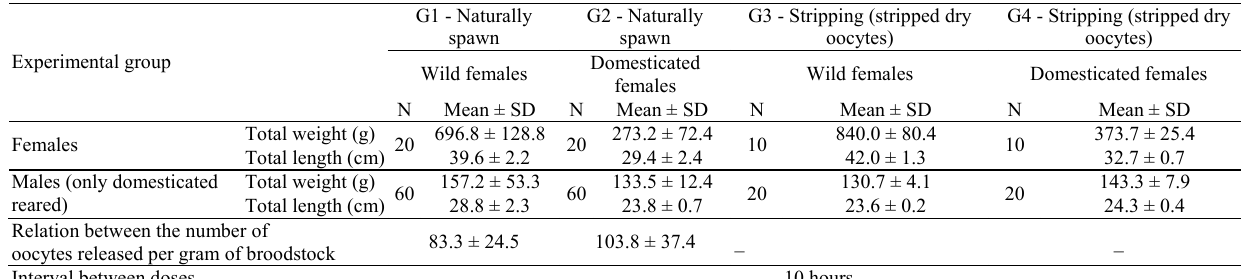
Table 1. Data on Salminus hilarii reproduction at the Ponte Nova Fish Farm during their reproductive periods (from: 2005 to 2007). Four artificial reproductions for G1 and G2 and two artificial reproductions for G3 and G4 were obtained on different days using different animals. Data are presented as the mean ± Standard error of the